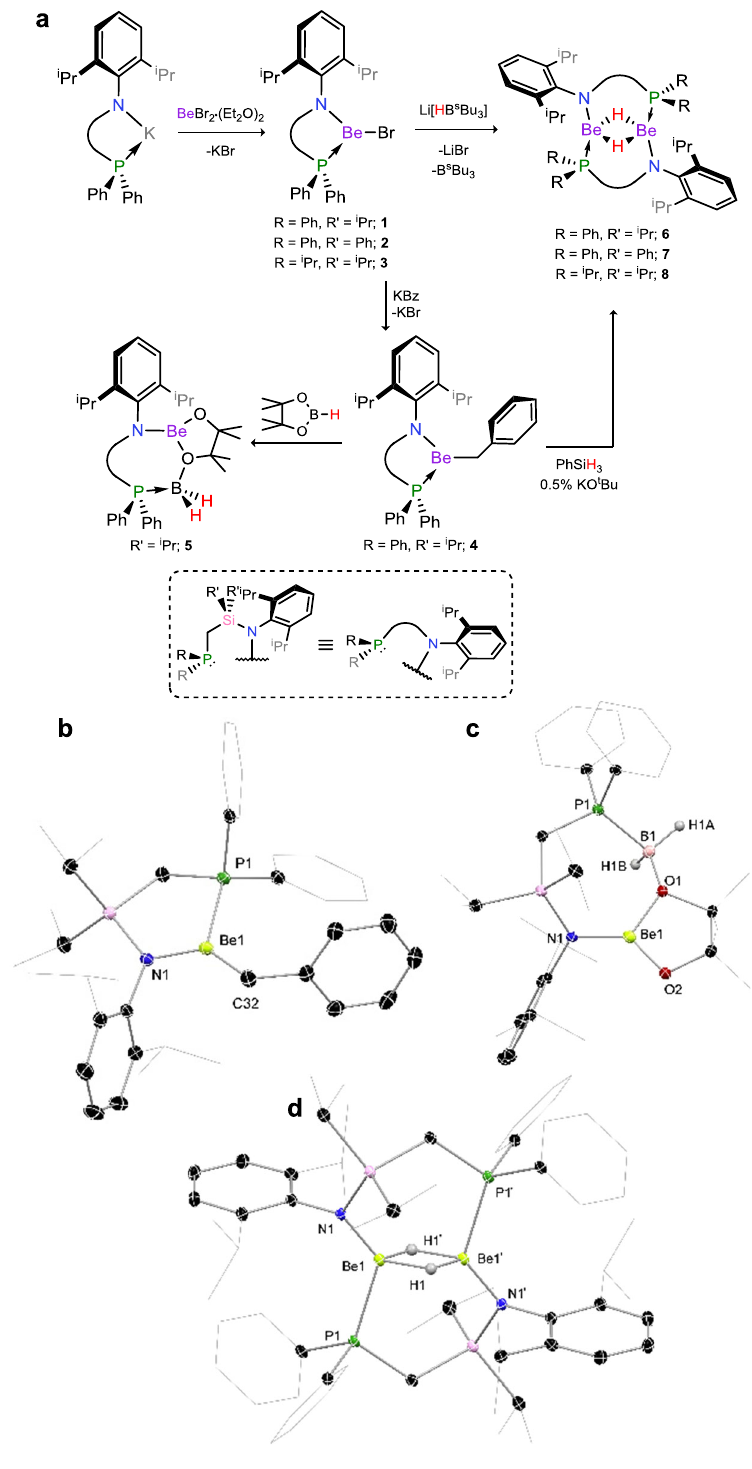
Fig. 2 Synthesis of compounds 1 – 8, and the X-ray crystal structures of 4 – 6. Beryllium hydride complexes 6 – 8 can be synthesised via addition of a hydrido-borate to amido-beryllium bromides, 1 – 3 , or through addition of PhSiH 3 to the amido-beryllium benzyl complex 4 in the presence of a strong base. Addition of pinacol borane (HBpin) to 4 leads to transient hydride formation followed by HBpin activation in 5 . a Synthesis of compounds 1 – 8 . b Solid state structure of complex 4 . c Solid state structure of complex 5 . d Solid state structure of complex 6 . Thermal ellipsoids for 4 – 6 at 30% probability. Selected distances (Å) and angles (°) for 4 : Be1 – C32 1.761(4); Be1 – N1 1.590(3); Be1 – P1 2.217(3); P1 – Be1 – C32 126.9(1); C32 – Be1 – N1 132.2(2); N1 – Be1 – P1 100.8(1). For 5 : Be1 – O1 1.633(4); Be1 – O2 1.489(3); B1 – O1 1.510(4); P1 – B1 1.952(3); Be1 – N1 1.615(3). For 6 : Be1 – P1 2.249(5); Be1 – N1 1.623(4); Be1 – Be1 ′ 2.125(6); Be1 – H1 1.43(4); Be1 – H1 ′ 1.50(3); P1 – Be1 – Be1 ′ 105.1(2); N1 – Be1 – Be1 ’ 128.9(3).